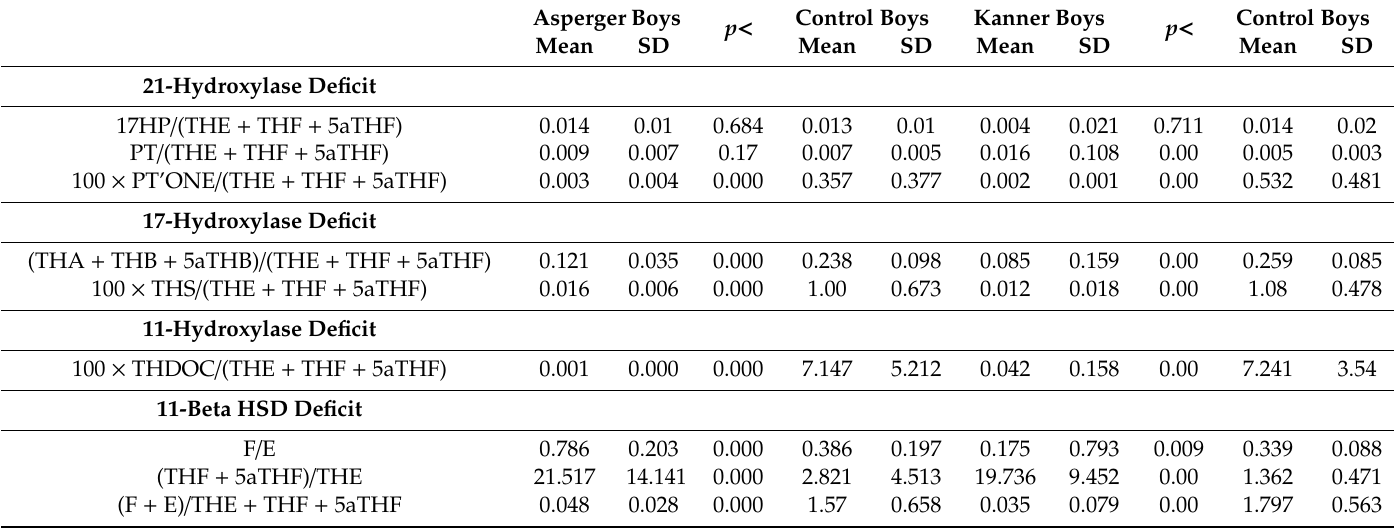
Table 2. Enzyme activities for boys with Asperger syndrome ( n = 20) versus individually pairwise matched controls ( n = 20) and boys with Kanner syndrome ( n = 21) versusindividuallypairwisematchedcontrols( n = 21). Datagivenasratioofmetabolites(mmol / L)tourinecreatinine( µ mol / L).(THA = Tetrahydrodehydrocorticosteron; THB = Tetrahydrocorticosteron; 5aTHB = 5a-Tetrahydrocorticosteron; THS = Tetrahydrosubstance S; HP = 17-Hydroxypregnalonon; PT = Pregnanetriol; PT’ONE